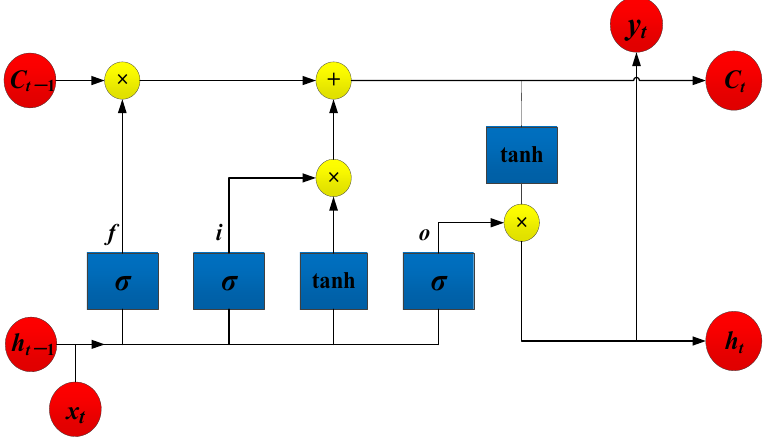
Figure 2. The network architecture of LSTM.